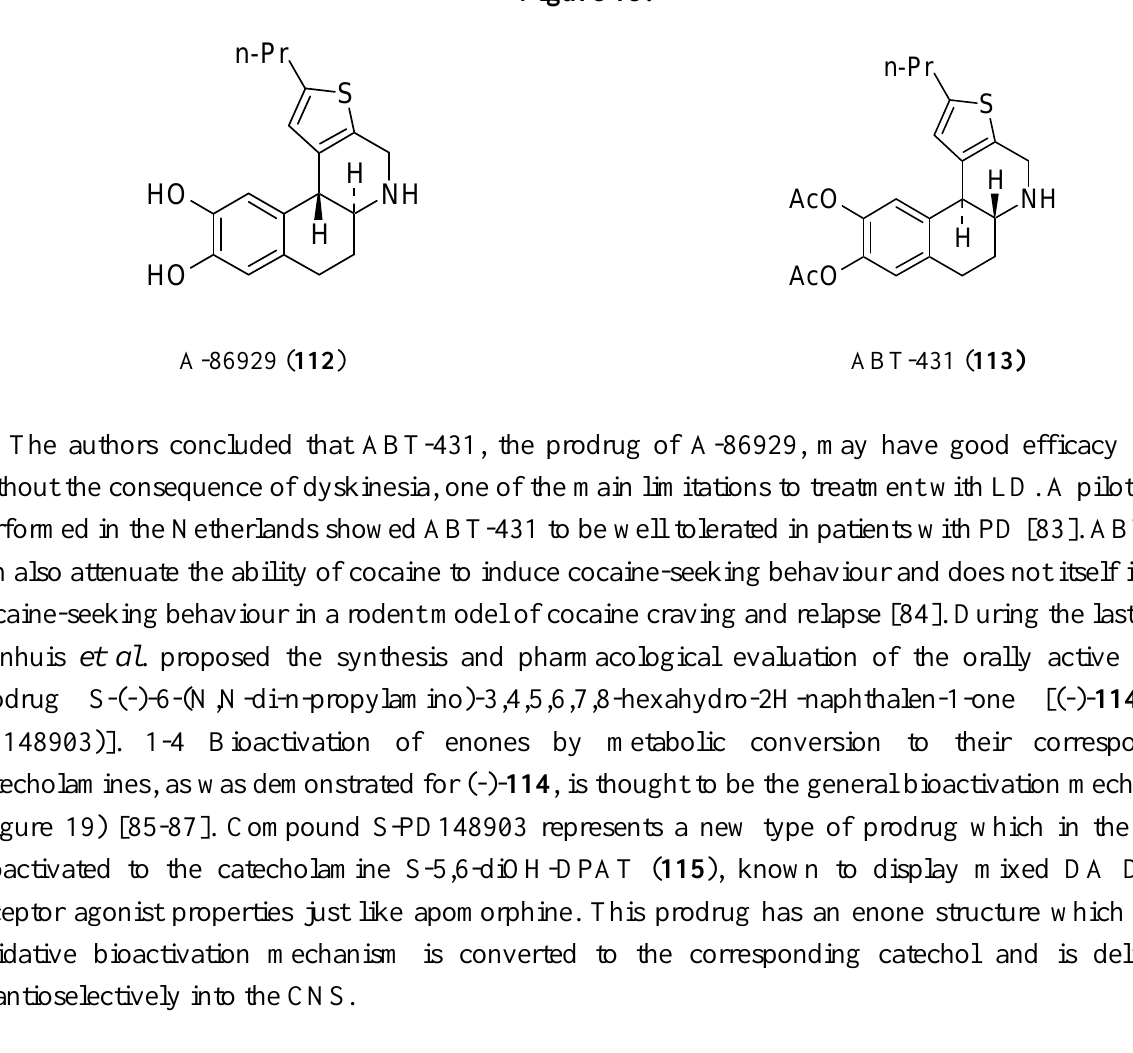
Figure 19 . Bioactivation of compound S-PD148903